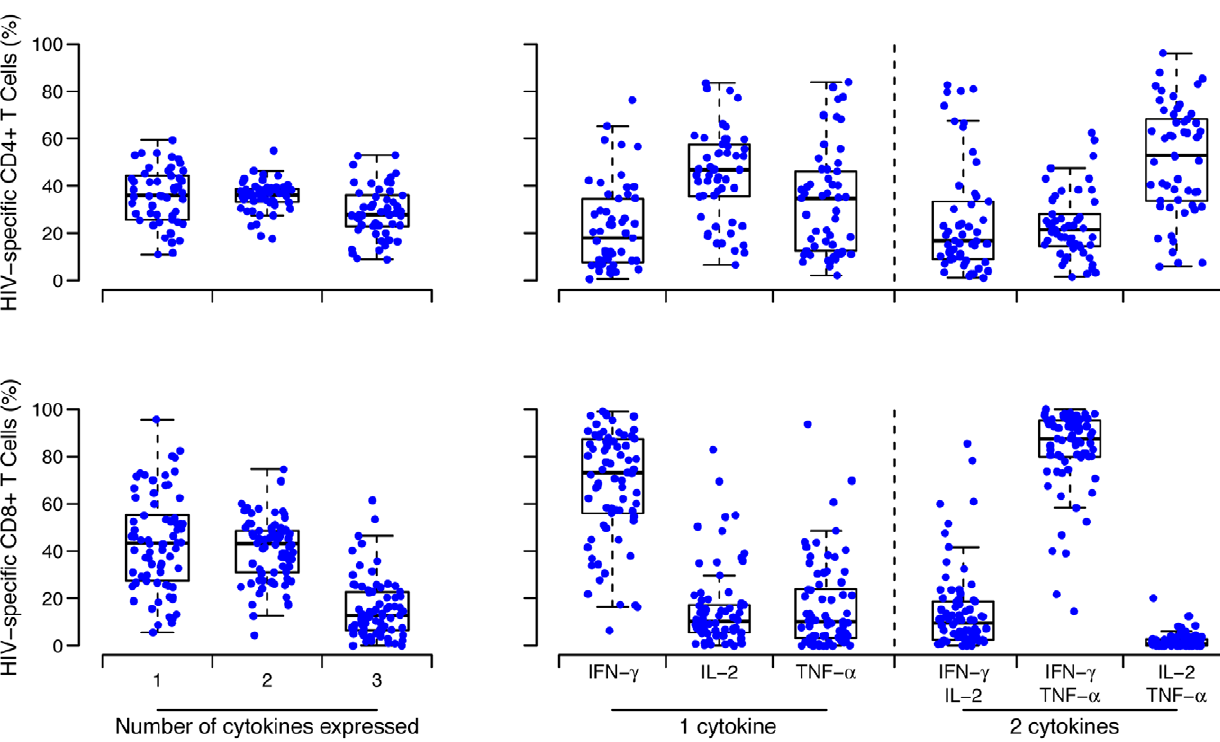
Figure 4. Polyfunctional CD4 + and CD8 + T-cell IFN- c , TNF- a and IL2 cytokine responses. The left graphs show the percentage of the HIV- specific CD4 + (upper panel) or CD8 + (lower panel) T-cells that are producing one, two or three cytokines in the vaccine recipients. Intracellular cytokine staining analyses were done on PBMC obtained six weeks after the rAd5 boost. The right graphs depict the percentage of cells producing interferon- c , interleukin-2 or tumor necrosis factor- a in those cells producing one cytokine (middle panels), and the percentage of cells co-producing two cytokines (panels on the right). The boxplots show the distribution of responses in positive responders only. The box indicated the median and inter-quartile range; whiskers extend to 1.5 times the inter-quartile range from the upper or lower